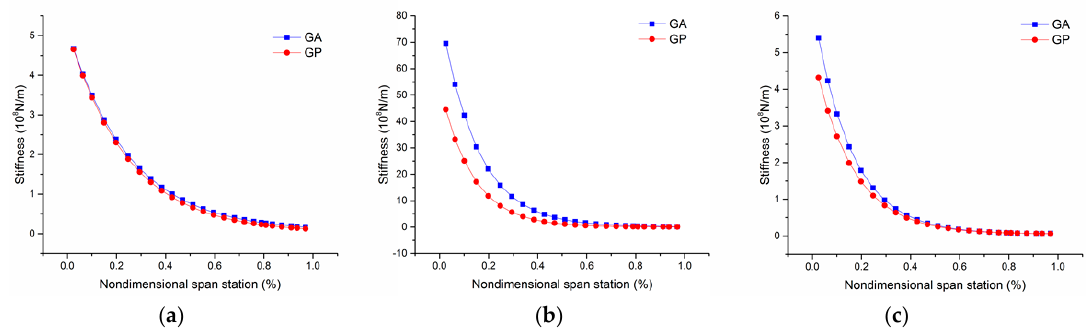
Figure 9. Stiffness comparison between the GA and GP methods. ( a ) Vertical bending; ( b ) Figure 9. Sti ff ness comparison between the GA and GP methods. ( a ) Vertical bending; ( b ) Horizontal Horizontal bending; ( c ) Torsional. bending; ( c )